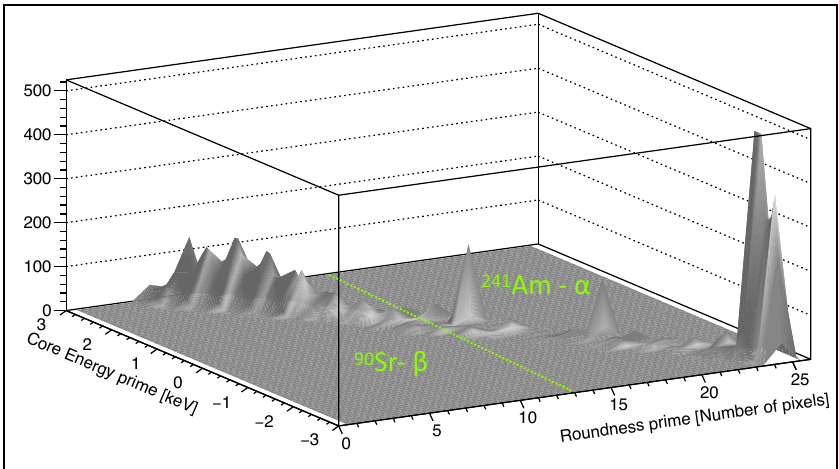
Figure 5. The three-dimensional plot ( R’ , C’ ) obtained for Am-241 and Sr-90 sources. α particles can be discriminated from β particles using a cut on R’ ≥ 13 as shown by the dotted line in figure.